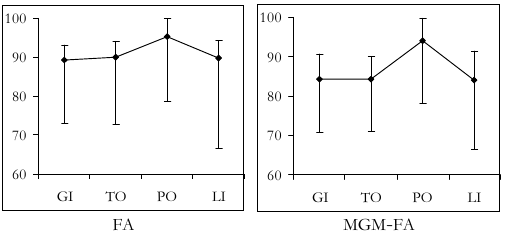
Figure 4 – Mean value (dot) and range of p , computed across the 25 combinations of discretization types, obtained by the FA (left-hand side) and the MGM - FA (right-hand side) studies applied to the data set with λ =[0.45,